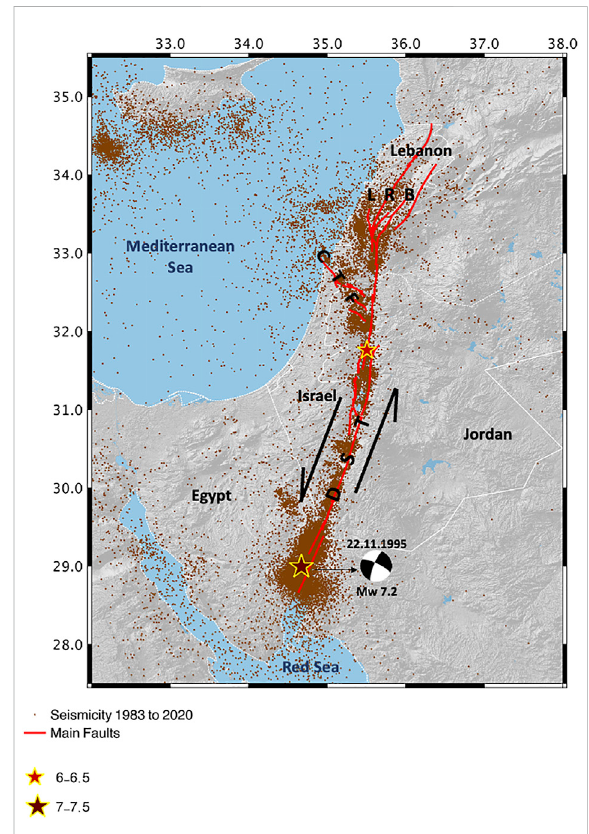
FIGURE 1 Seismic map of the study area showing the main fault segments of the Dead Sea transform (DST) and of the northwest orientated Carmel-Tirza fault system (CTF) system (Sharon et al., 2020); recorded seismicity of 1983 – 2020 (expansion of Wetzler and Kurzon 2016 catalogue), highlighting the most signi fi canteventsinthepastcentury:the1927Msixatthenorthern Dead Sea, and the M W 7.2 at the Gulf of Elat (Aqaba). Black arrows denote the relative plate motion along the